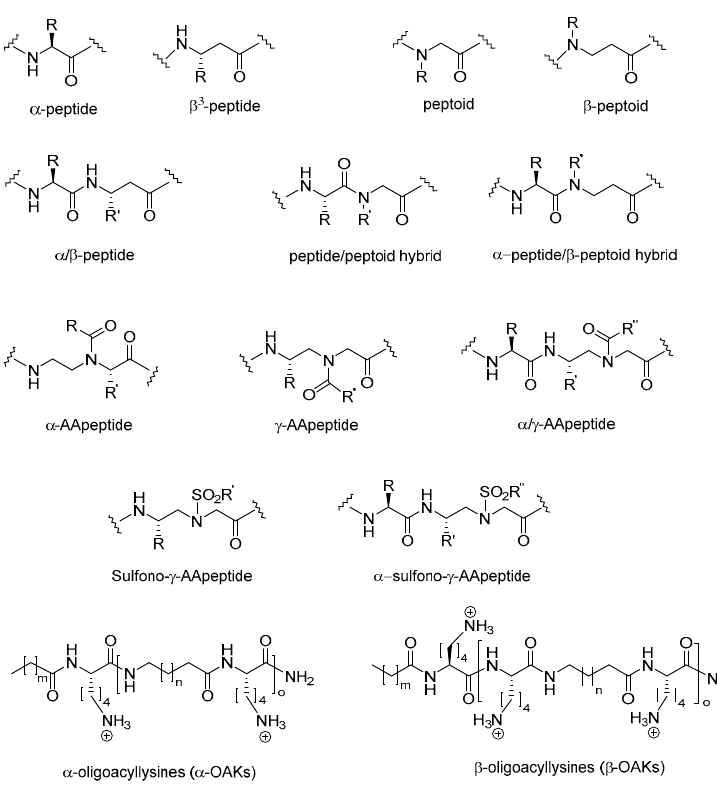
Figure 1. Basic structures of peptidomimetics discussed in the present review.